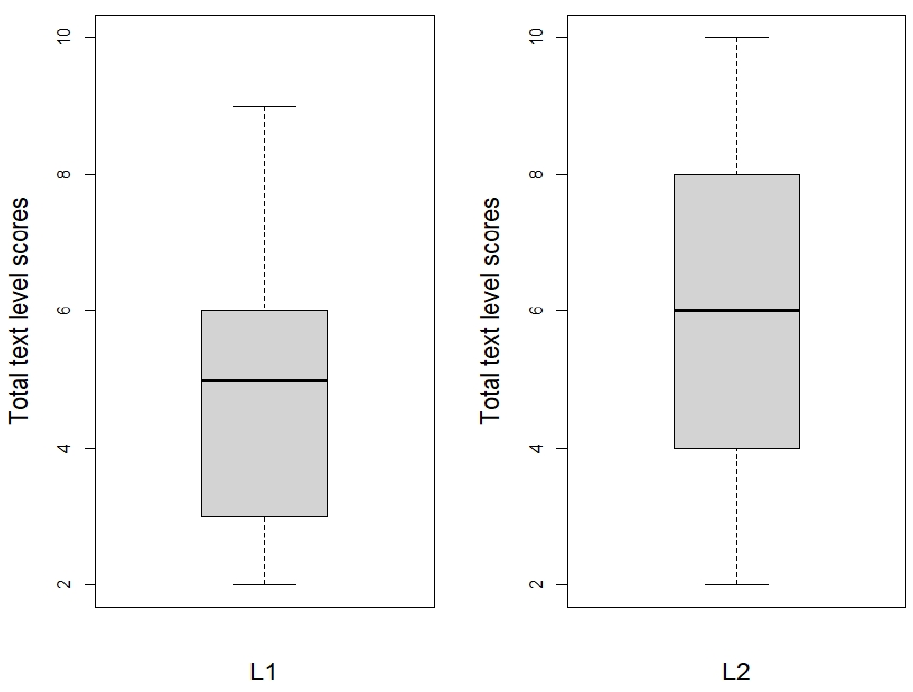
Figure 1. Total text competence scores in L1 and L2 across text types.